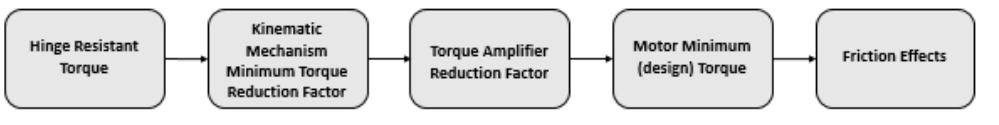
Figure 7. Actuation design process.